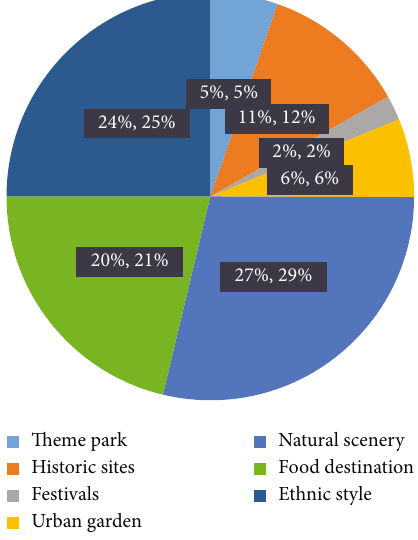
Figure 7: Preferences of tourist